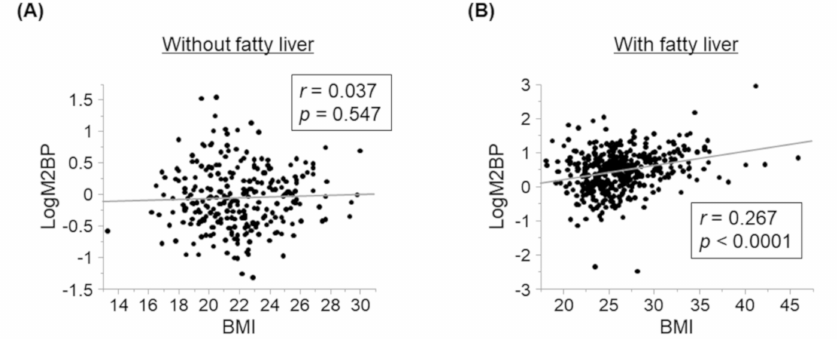
Figure 1. Relationships between serum M2BP levels and body mass index at baseline in subjects with or without fatty liver disease. ( A ) Relationships between serum M2BP levels and BMI in subjects without fatty liver. There were no significant relationships between serum M2BP levels and BMI in subjects without fatty liver. ( B ) Relationships between serum M2BP levels and BMI in subjects with fatty liver. There were significant positive relationships between serum M2BP levels and BMI in subjects with fatty